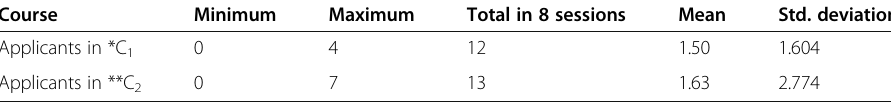
Table 6 Descriptive statistics for the TOEFL iBT applicants ’ oral